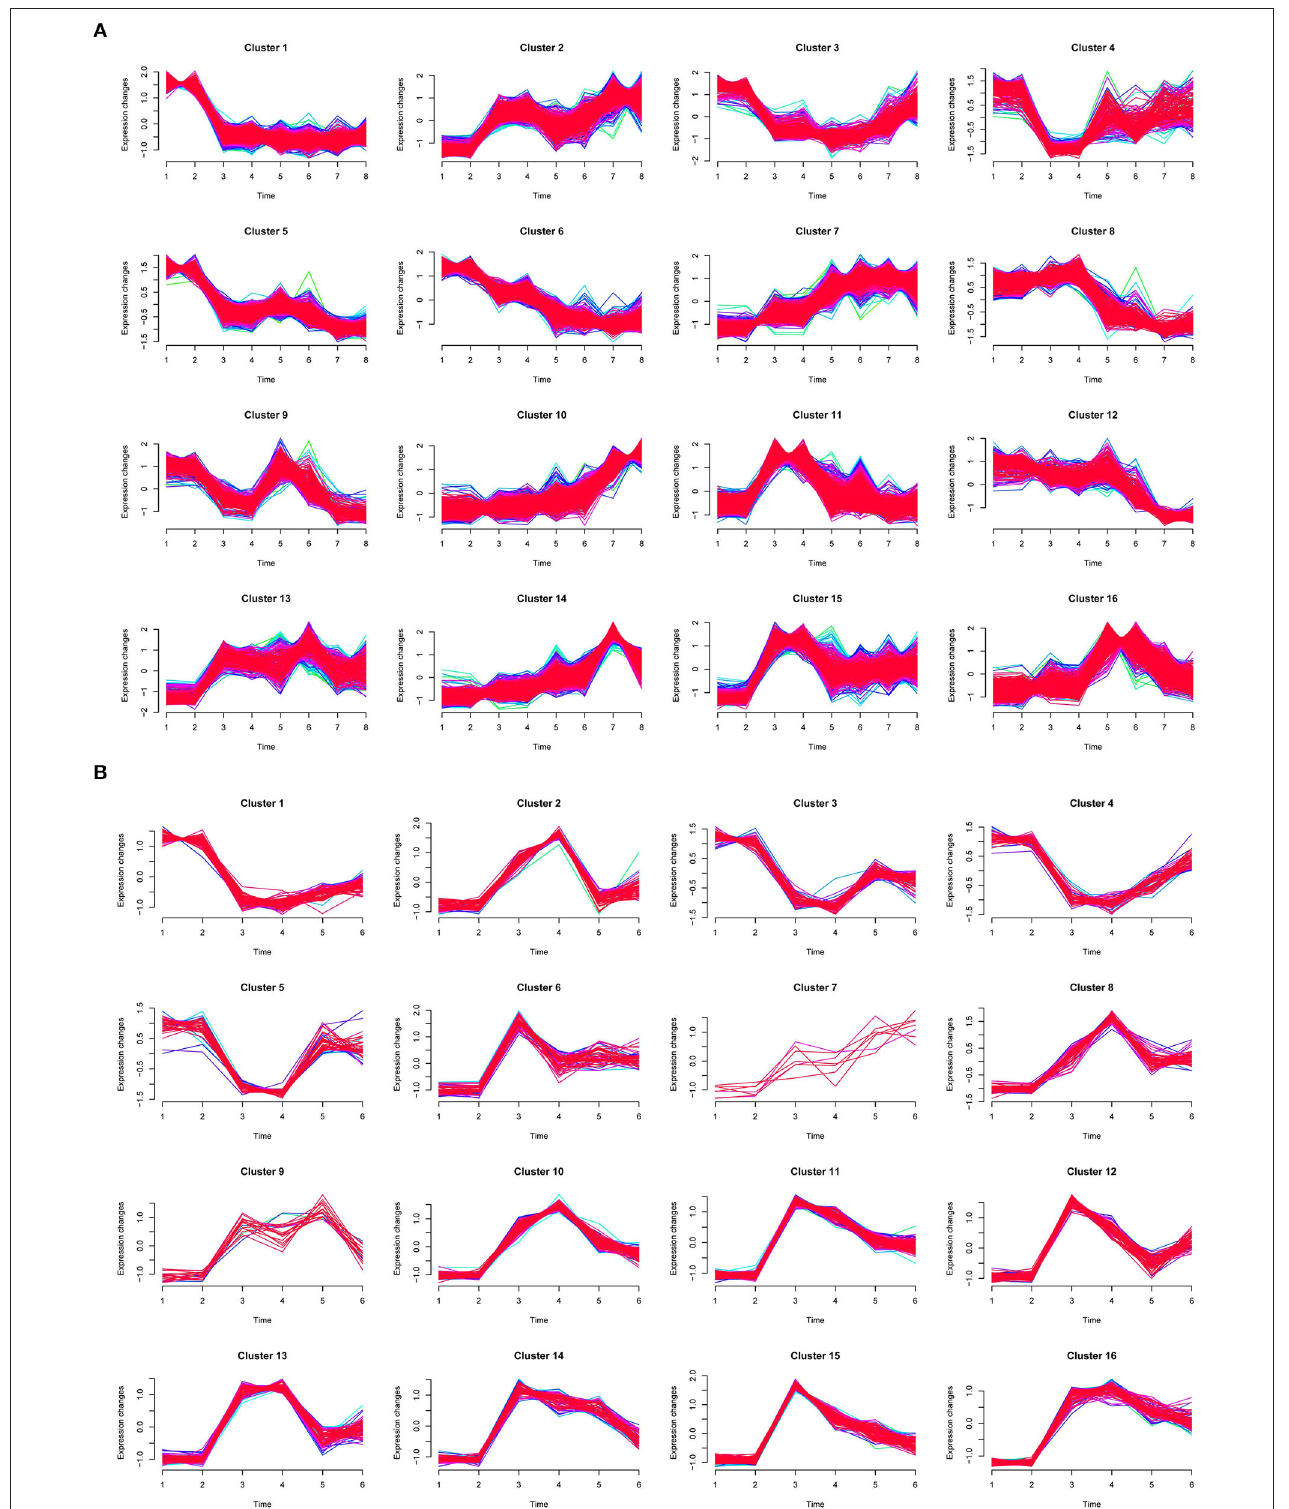
FIGURE 4 | Time-series clustering of DEGs for dehydration (A) and cold (B) treatments. In (A) , 1 and 2, 3 and 4, 5 and 6, and 7 and 8 on X -axis indicated two biological repeats of CK, G2, G4, and G8, respectively. In (B) , 1 and 2, 3 and 4, and 5 and 6 on X -axis indicated two biological repeats of CK, D2, and D4, respectively.